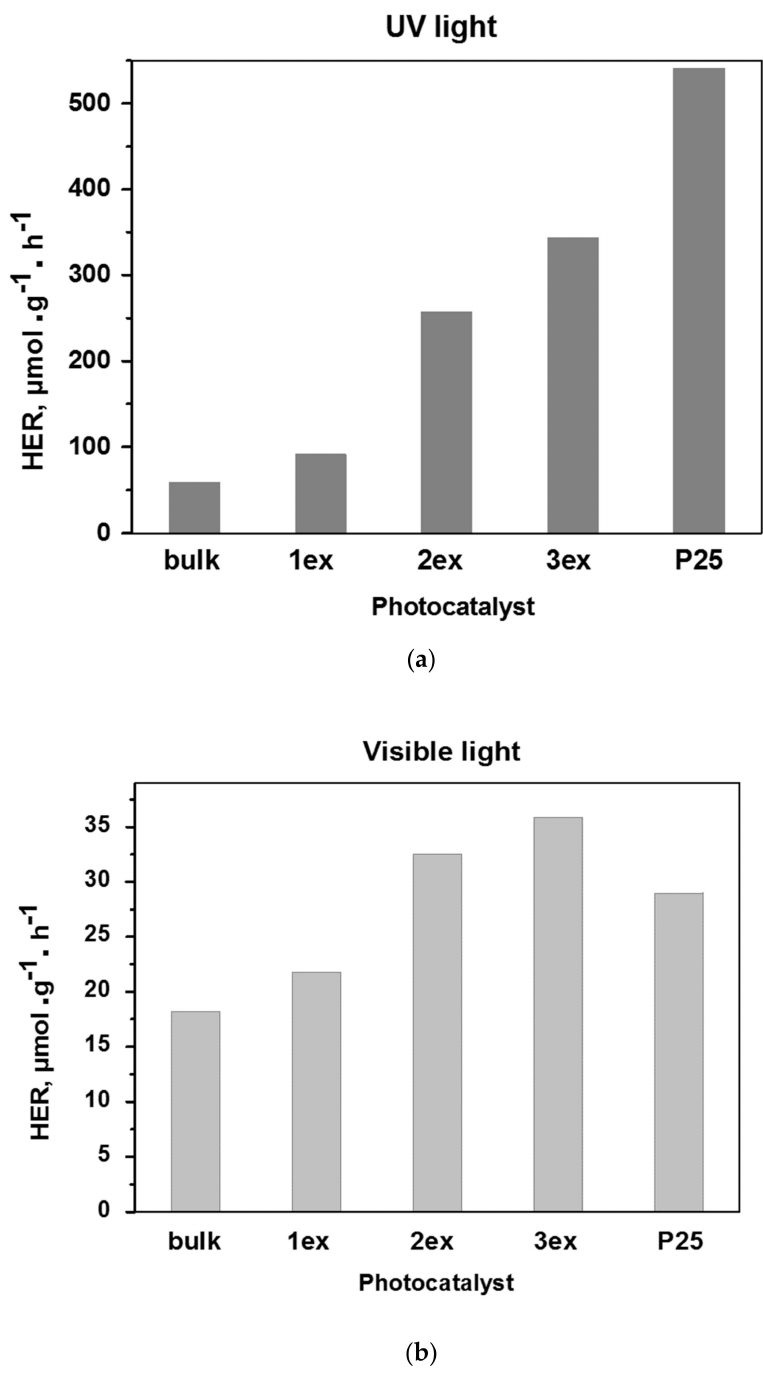
Figure 10. Photocatalytic activity of the g-C 3 N 4 (bulk, 1ex, 2ex and 3ex) and P25 in H 2 evolution under UV ( a ) and visible ( b )